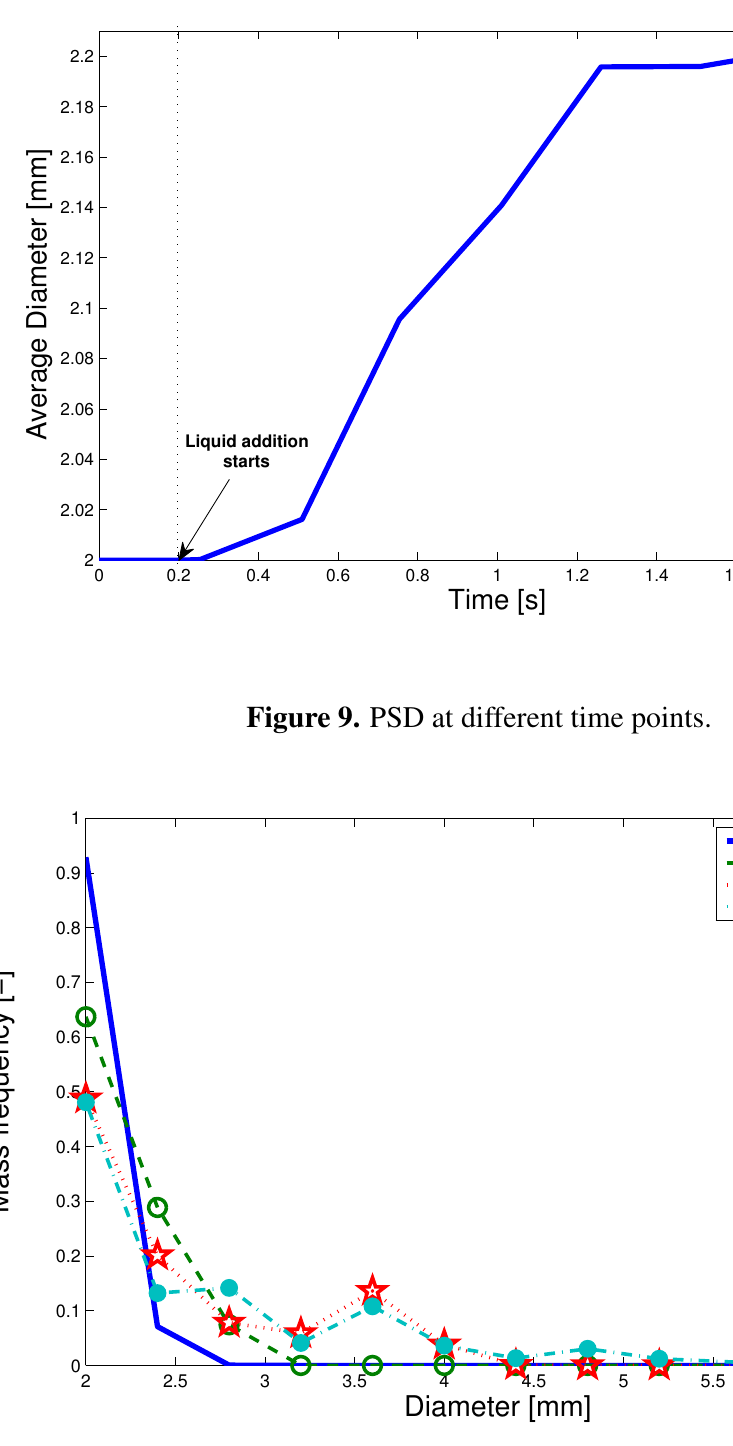
Figure 8. Average diameter vs. time.